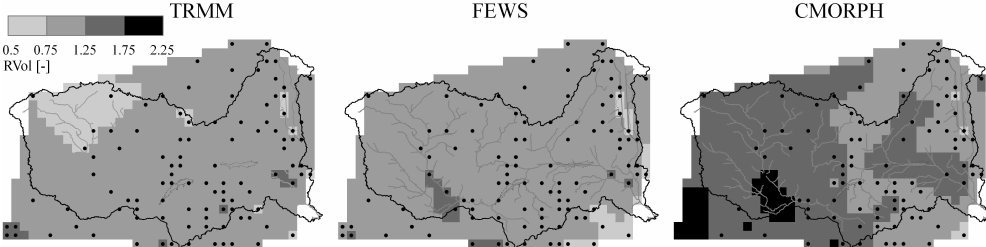
Fig. 9. Spatial repartition of the volume ratio (RVol) for TRMM, FEWS and CMORPH estimates versus GCPP data at a monthly time step for the period 2003 to